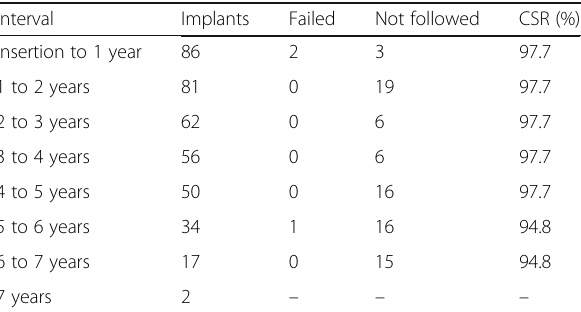
Table 4 Implant survival, life table analysis Interval